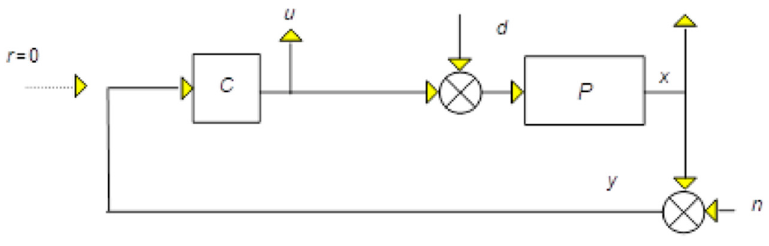
Figure 2. Typical control block graph.